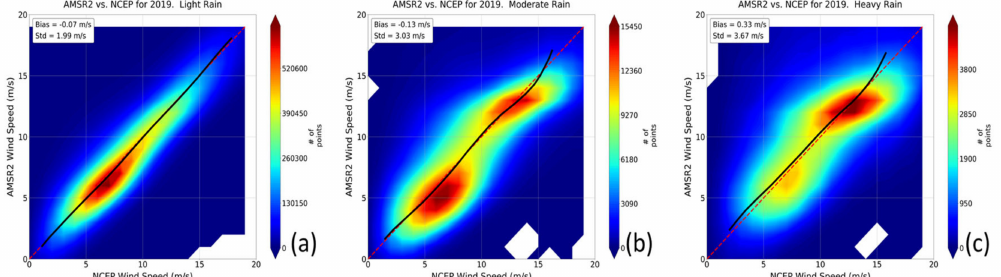
Figure 14. 2-dimensional probability density function between global AMSR2 all-weather wind speeds (y-axis) and NCEP wind speeds (x-axis), for different rain regimes. The dashed red line indicates the 1:1 (y = x) line. The full black line indicates the symmetrized binned averages, which are obtained by binning y with respect x, x with respect to y, and taking the arithmetic average between the two cases. The bin sizes are 1 m/s. ( a ) Light rain (AMSR2 rain rate above 0 and below 4 mm/h). ( b ) Moderate rain (AMSR2 rain rate above 4 and below 8 mm/h). ( c ) Heavy rain (AMSR2 rain rate above 8 mm/h). The values of bias and standard deviation are also indicated in each